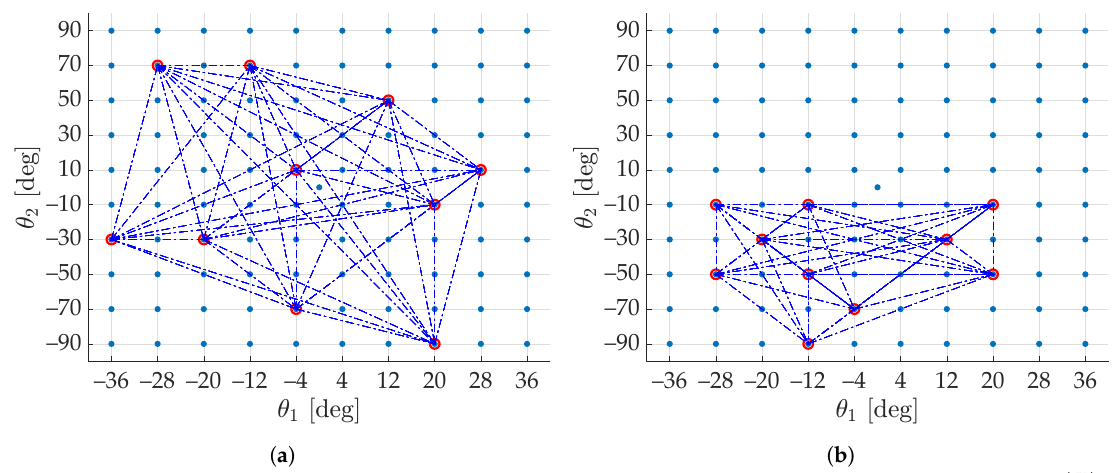
Figure 11. Complete graphs on the nodes in C H of Figure 10: the K red points are the vertices, whereas the